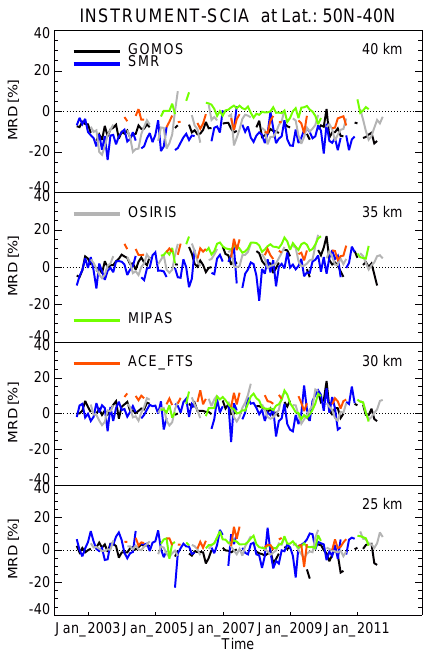
Figure 2. Same as Fig. 1, but for the northern middle latitudes (50– 40 ◦